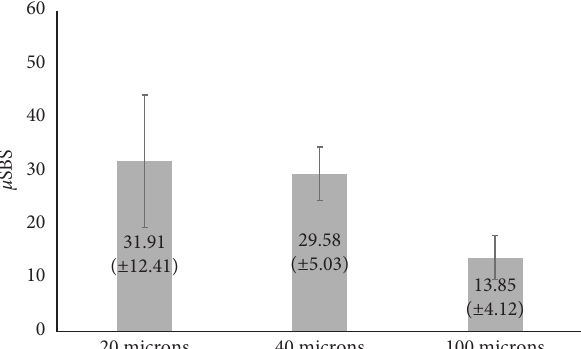
Figure 5: Mean microshear bond strength (MPa) and standard deviations (SD) among the study groups. p value � 0.003 ∗ ( ∗ statistically significant difference at p value ≤